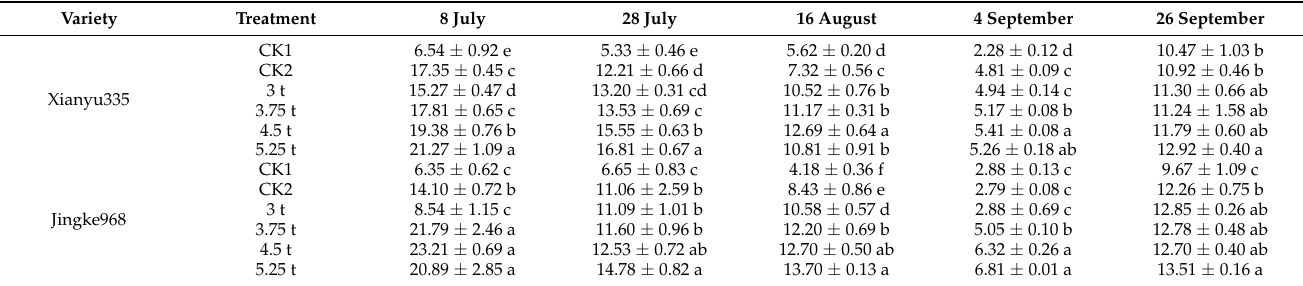
Table 2. Effects of carbon-based fertilizer on soil nitrate nitrogen content